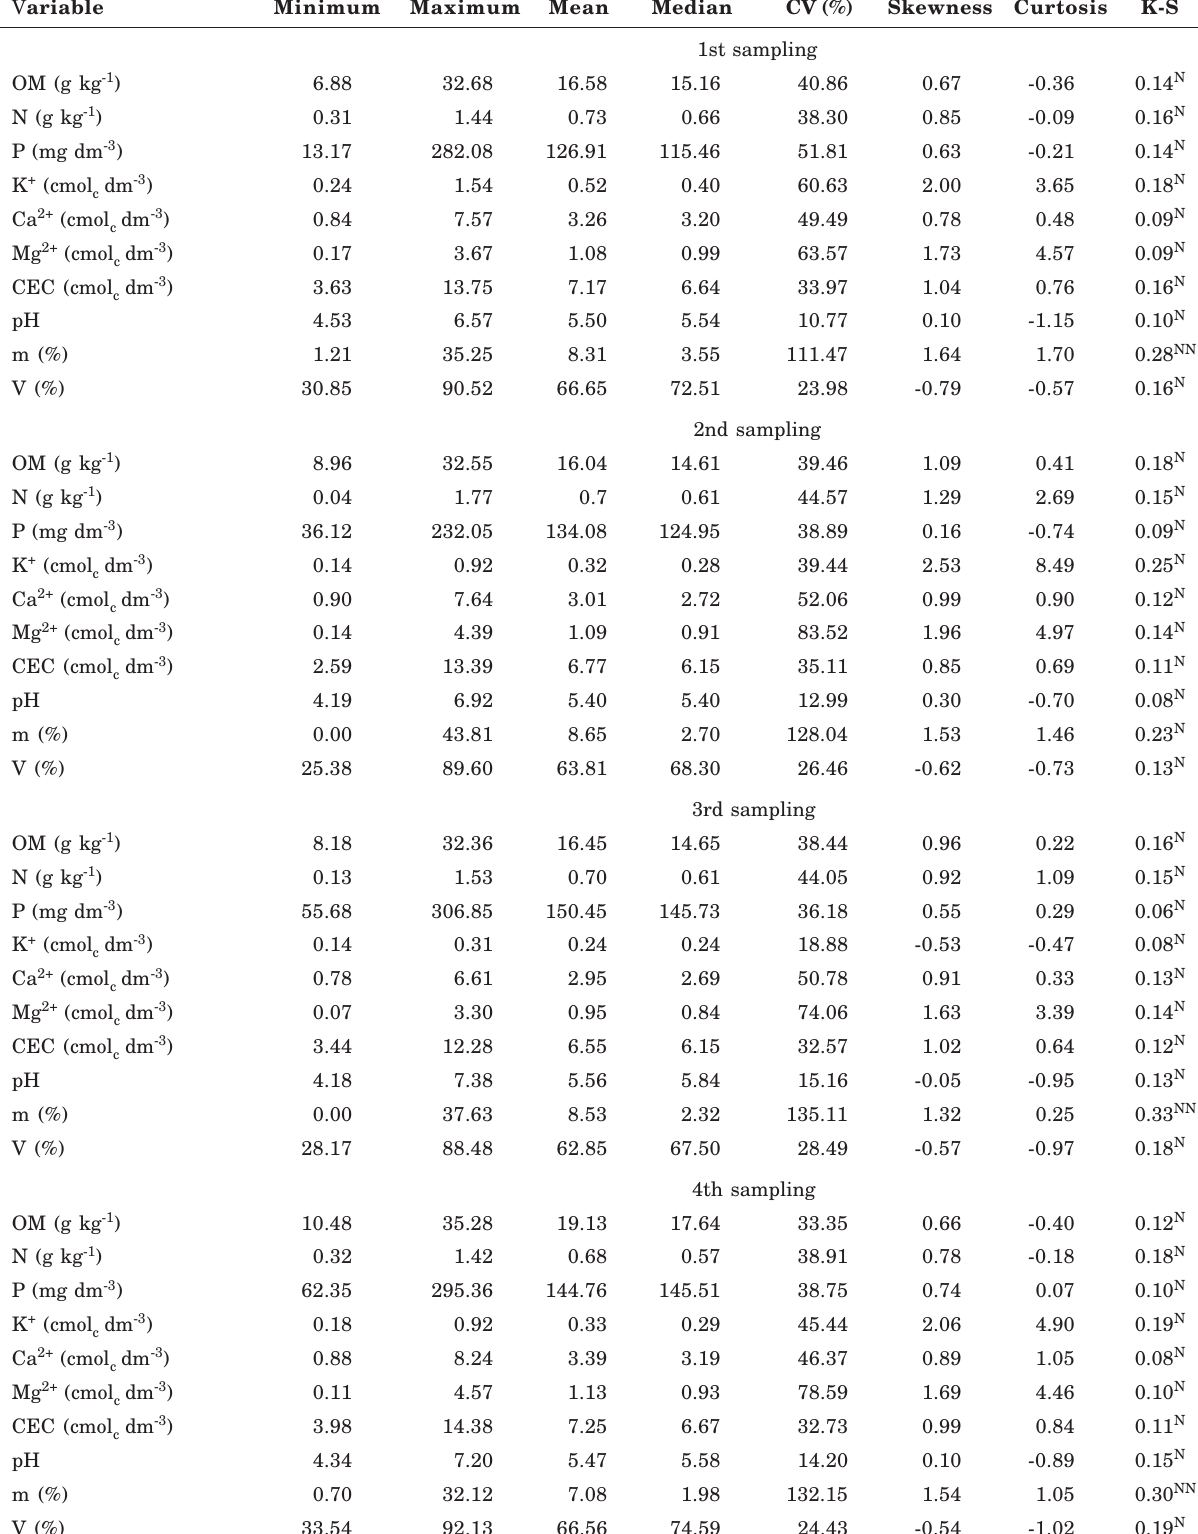
Table 1. Soil chemical variables of strawberry fields at four sampling